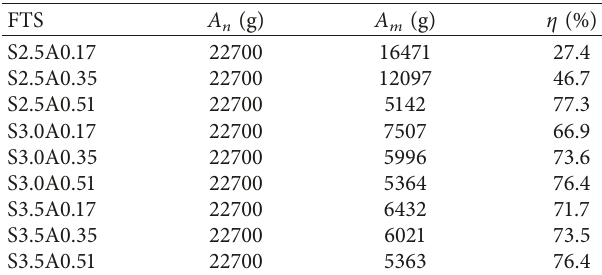
Figure 18: Acceleration-time curves. Acceleration response of (a) outer protective structure, (b) scientific instrumentations with a thickness of 2.5mm, (c) scientific instrumentations with a thickness of 3.0mm, and (d) scientific instrumentations with a thickness of 3.5mm. Table 6: Impact isolation efficiency of